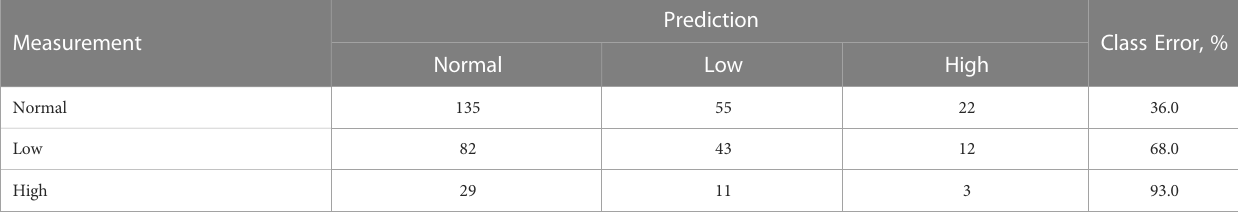
TABLE 3 Confusion matrix for classi fi cation of heart rate data given as numbers of observations obtained from a sensor classi fi ed into categorical responses re fl ecting “ Normal ” , “ Low ” , and “ High ” heart rates 1 .